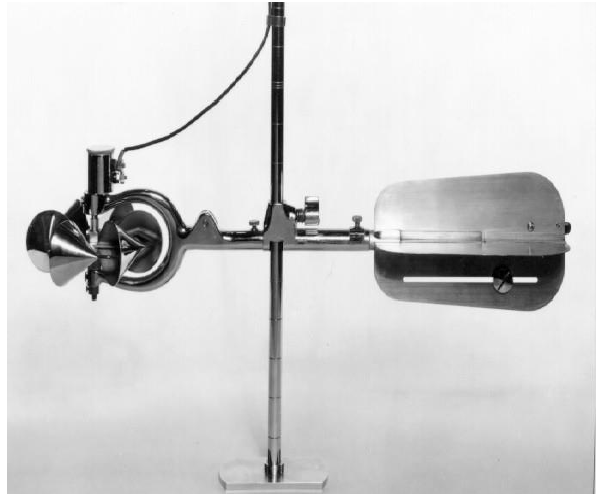
Figure 2: Pictorial view of Pygmy type Current